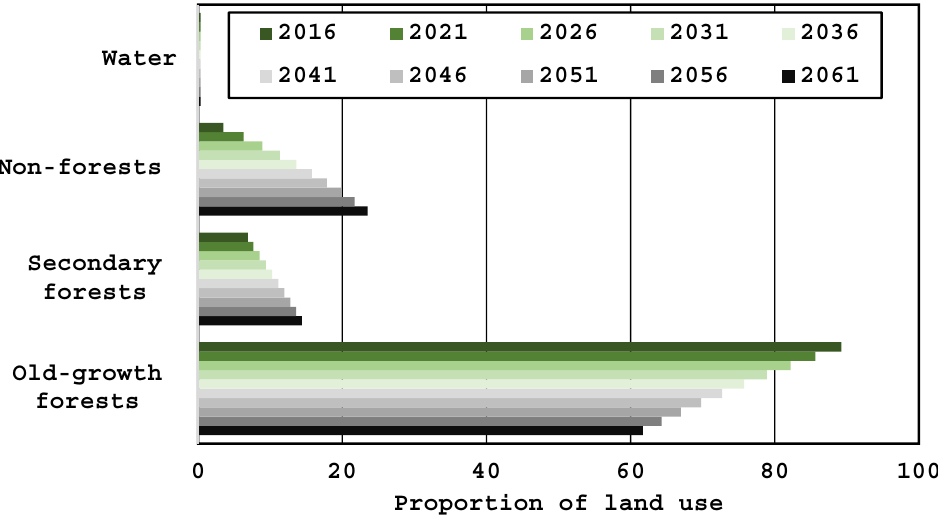
Figure 9. Future evolution of the composition of the occupation according to the scenario of SEM.